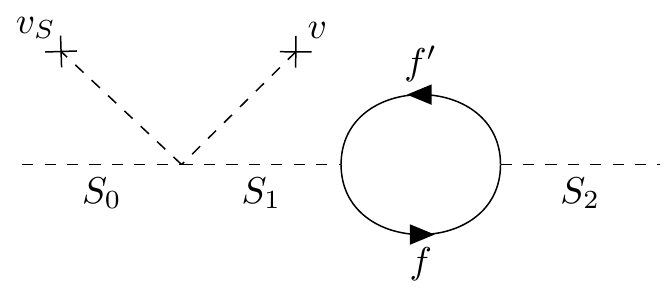
Figure 1 . One-loop mixing of h and A